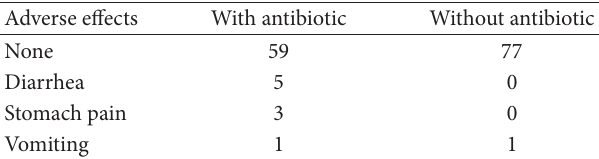
Table 2: Drug adverse effects in both groups.